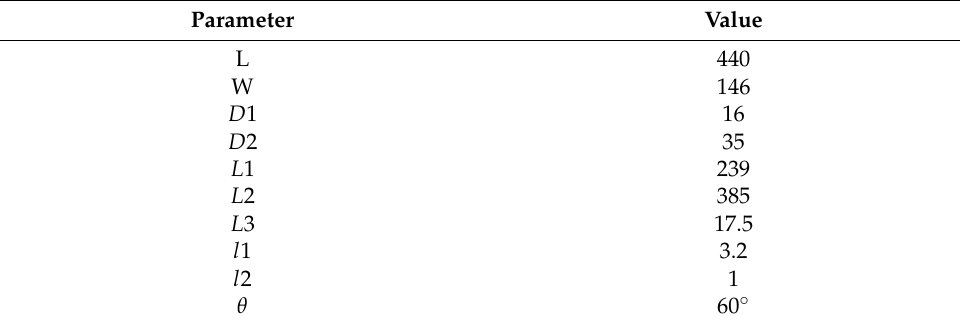
Figure 7. Model and size of 8-element Vivaldi array antenna. Table 5. Array antenna parameters